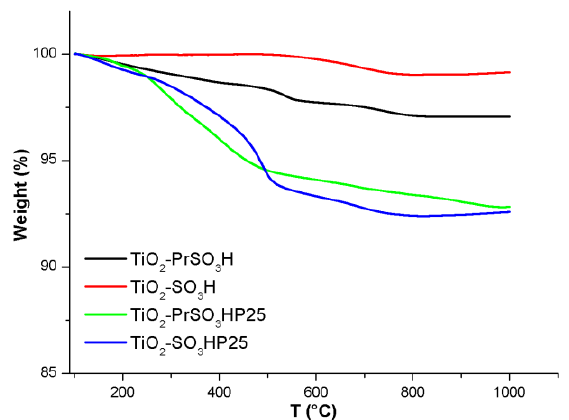
Figure 6. Thermogravimetric analysis of the functionalized TiO 2 catalysts.